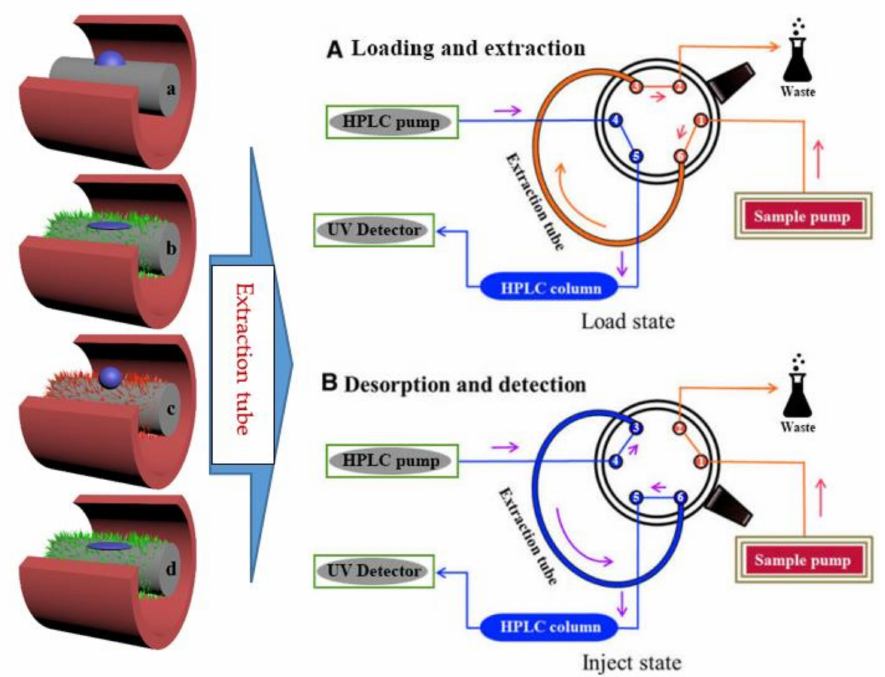
Figure 10. ( Left ) The fabricated wire with different surface wettability was inserted into the mi- croextraction tube. Symbol identification: (a) the pristine wire, (b) the superhydrophilic wrie, (c) the superhydrophobic wire and, (d) the UV-irradiated superhydrophilic wire. ( Right ) Schematic illustra- tion of in-tube SPME–HPLC online